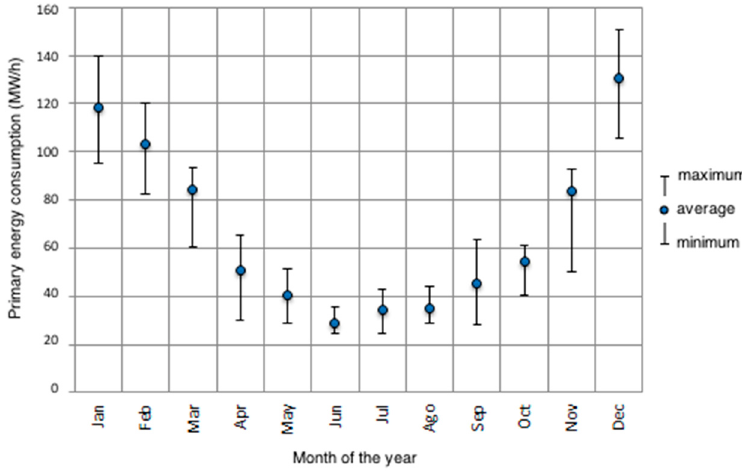
Figure 4. Trend of the average annual consumption of primary energy.